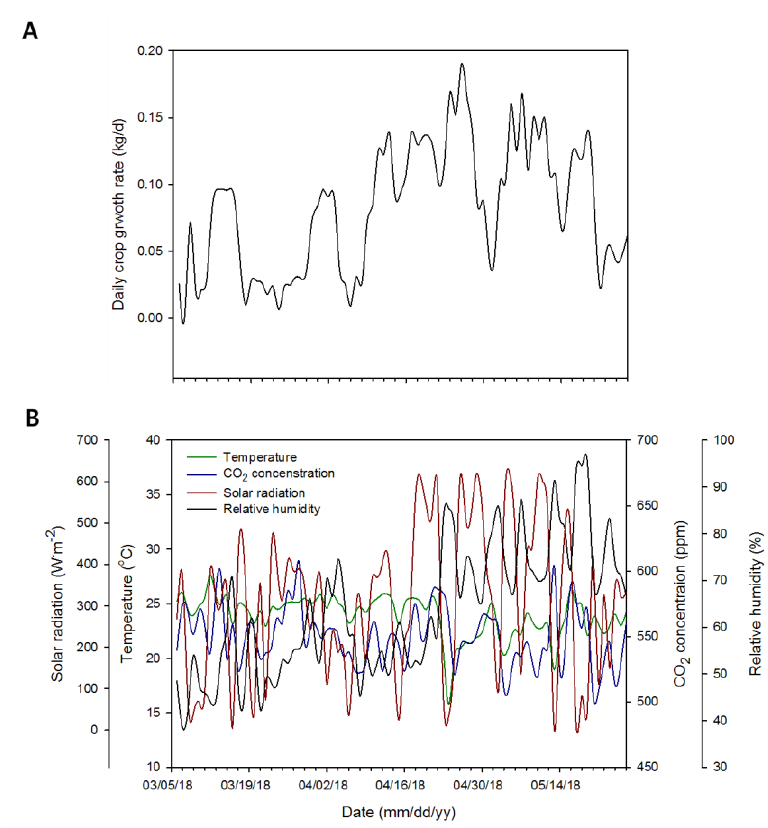
Figure 8. Crop growth rates measured by the system ( A ) and environmental conditions in the greenhouse ( B ) from 5 March to 26 March 2018. Daily crop growth rate was calculated as the difference in fresh weight calculated between current and previous measurement days.